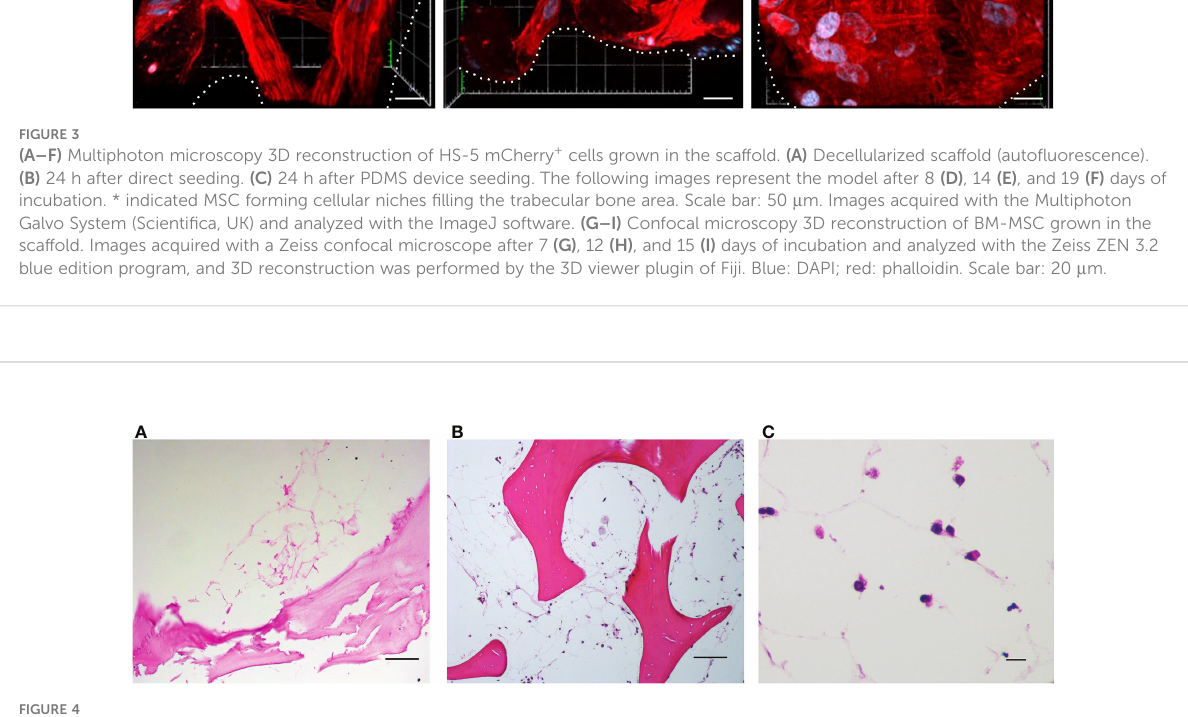
FIGURE 4 (A) Decellularized scaffold showing the extracellular matrix web; (B, C) recellularized scaffold after 12 days of incubation, in which HS-5 cells are clearly visible along the matrix web. Structure remaining after adipocyte removal is clearly visible. Hematoxylin/eosin staining. Scale bar: 100 m m (A, B) ; 10 m m (C)